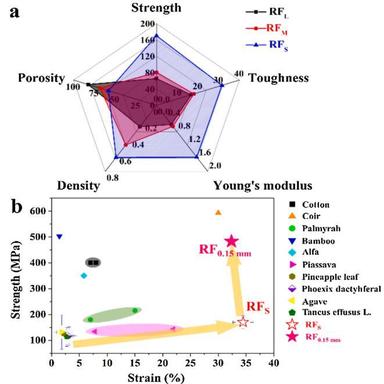
Comparison of the strength, toughness, Young's modulus, density, and porosity of RFL, RFM and RFS (a), and a comparison of the strain and strength of RFS, RF0.15mm, and other reported lignocellulosic fibers including cotton, coir, palmyrah, bamboo, alfa, pineapple leaf, phoexix dactyhferal, Agave, and tancus effusus L.